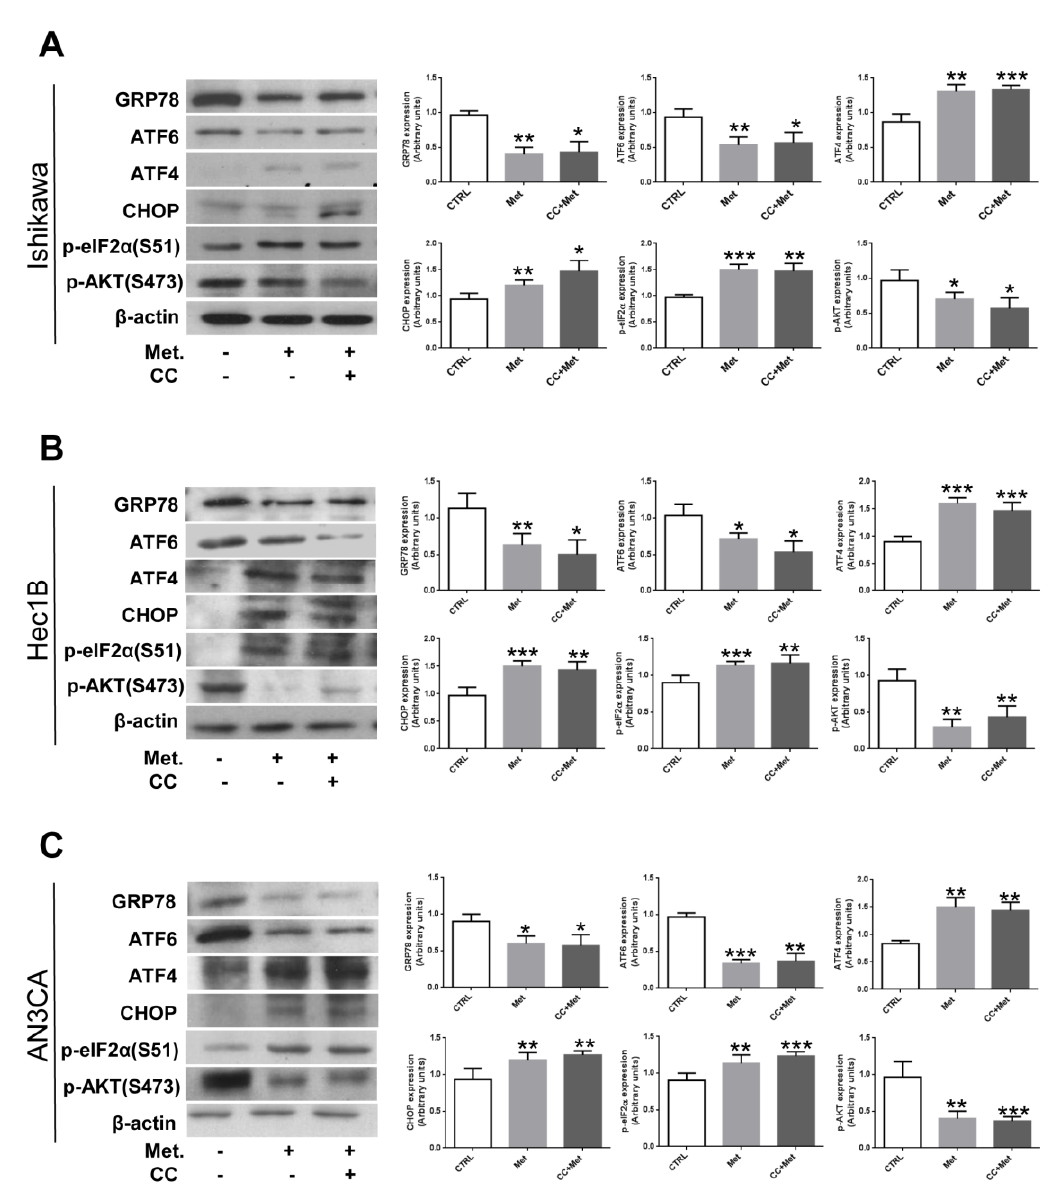
Figure 4. Metformin modulates the expression/phosphorylation of UPR proteins and AKT in an AMPK-independent manner in endometrial cancer cells. Ishikawa ( A ), HEC1B ( B ), or AN3CA ( C ) cells were treated or not for 24 h with 5 mM metformin in the presence or absence of 1 h pretreatment with 10 µ M CC. Total cellular proteins were extracted and Western blot experiments were performed with antibodies against GRP78, ATF6, ATF4, p-eIF2 α , p -AKT, or β -actin (loading control), as described in the Section 2.3. Values shown represent the mean ( ± s.d.) of three independent experiments. * p < 0.1; ** p < 0.05; *** p < 0.01.